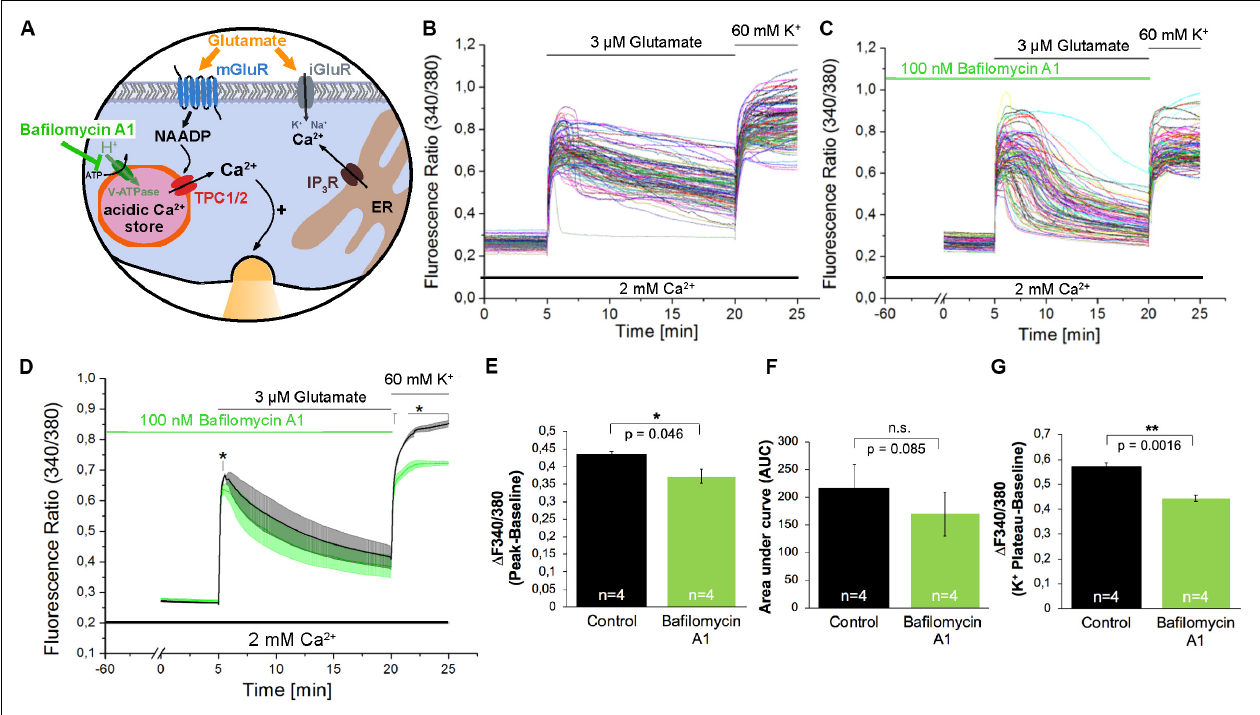
FIGURE 4 | The V-ATPase blocker Bafilomycin A1 does not affect glutamate-induced Ca 2 + increase in hippocampal neurons. (A) Model depicting the action of Bafilomycin A1 as inhibitor of H + transport into acidic organelles. (B,C) Representative traces of the glutamate-induced changes in the F340/380 fluorescence intensity values in hippocampal neurons without (B) and with (C) pretreatment with Bafilomycin A1 (100 nM). (D) Average traces are given as the arithmetic mean ± SEM of the averaged F340/380 fluorescence intensity values without (black, n = 745 cells) and with (green, n = 849 cells) Bafilomycin A1 (100 nM) pre-incubation. Data from independent C57Bl/6N preparations ( N = 4) are shown. During all experiments, the cells were remained in physiological solution containing 2 mM Ca 2 + . For measurements with Bafilomycin A1, the cells were pre-incubated for 60 min. After 5 min of baseline recording, the cells were stimulated with glutamate (3 µ M) for 15 min. For the last 5 min, the cells were stimulated with high potassium solution (60 mM K + ). The amplitude of the glutamate-induced calcium increase (E) as well as the AUC (F) and the amplitude of the high-potassium induced calcium transients (G) were analyzed. **: p < 0,01; *: p <